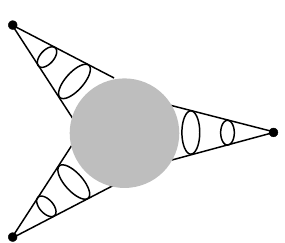
Figure 10. The three-point function of bilinears. This looks like the fermion six-point function, with fermions brought together in